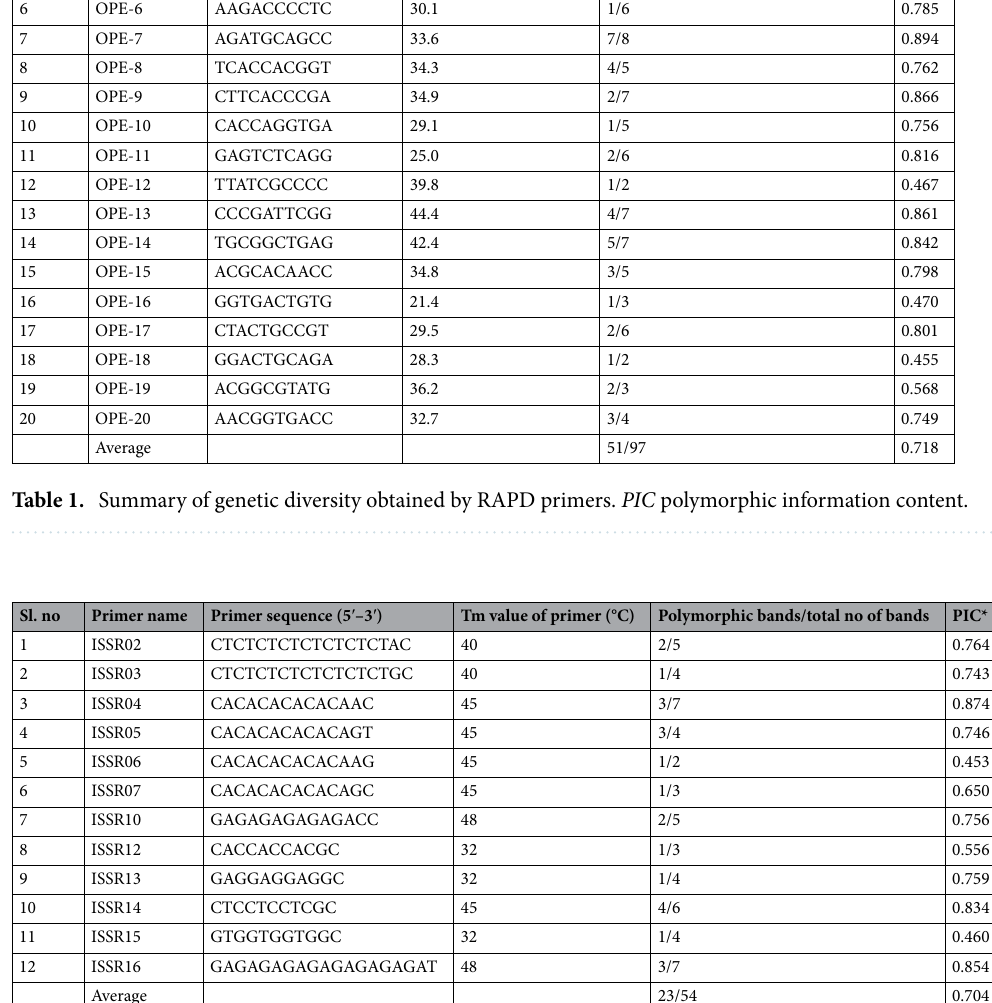
Table 2. Summary of genetic diversity obtained by ISSR primers. PIC polymorphic information content.